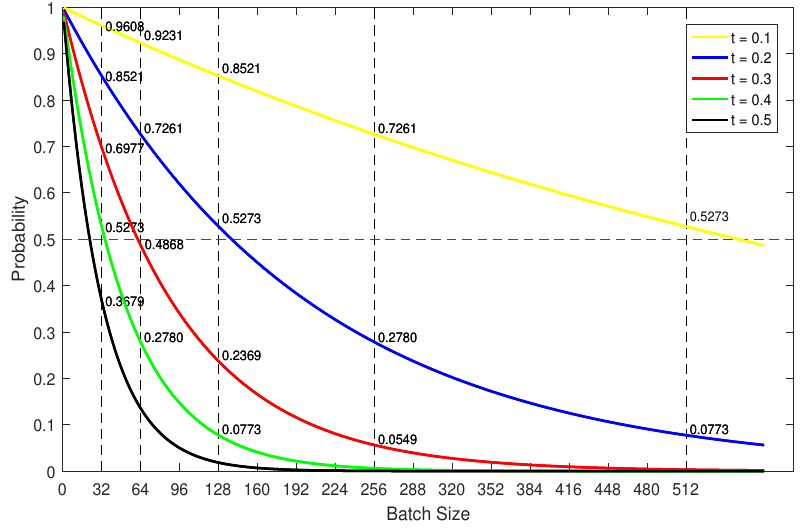
Figure 1. Illustration of the probability of | MMD em2 − MMD 2 | exceeding deviation t . The horizontal axis is batch size. The number next to the curve is the probability of exceeding different deviation t under the specific batch size. The figure shows that the probability of exceeding large deviation is high under the small batch size. Generally, the batch size in MMD-GANs is less than 128 and the deviation of loss function is large. Under the same deviation t , the probability of exceeding t decreases with increasing of batch